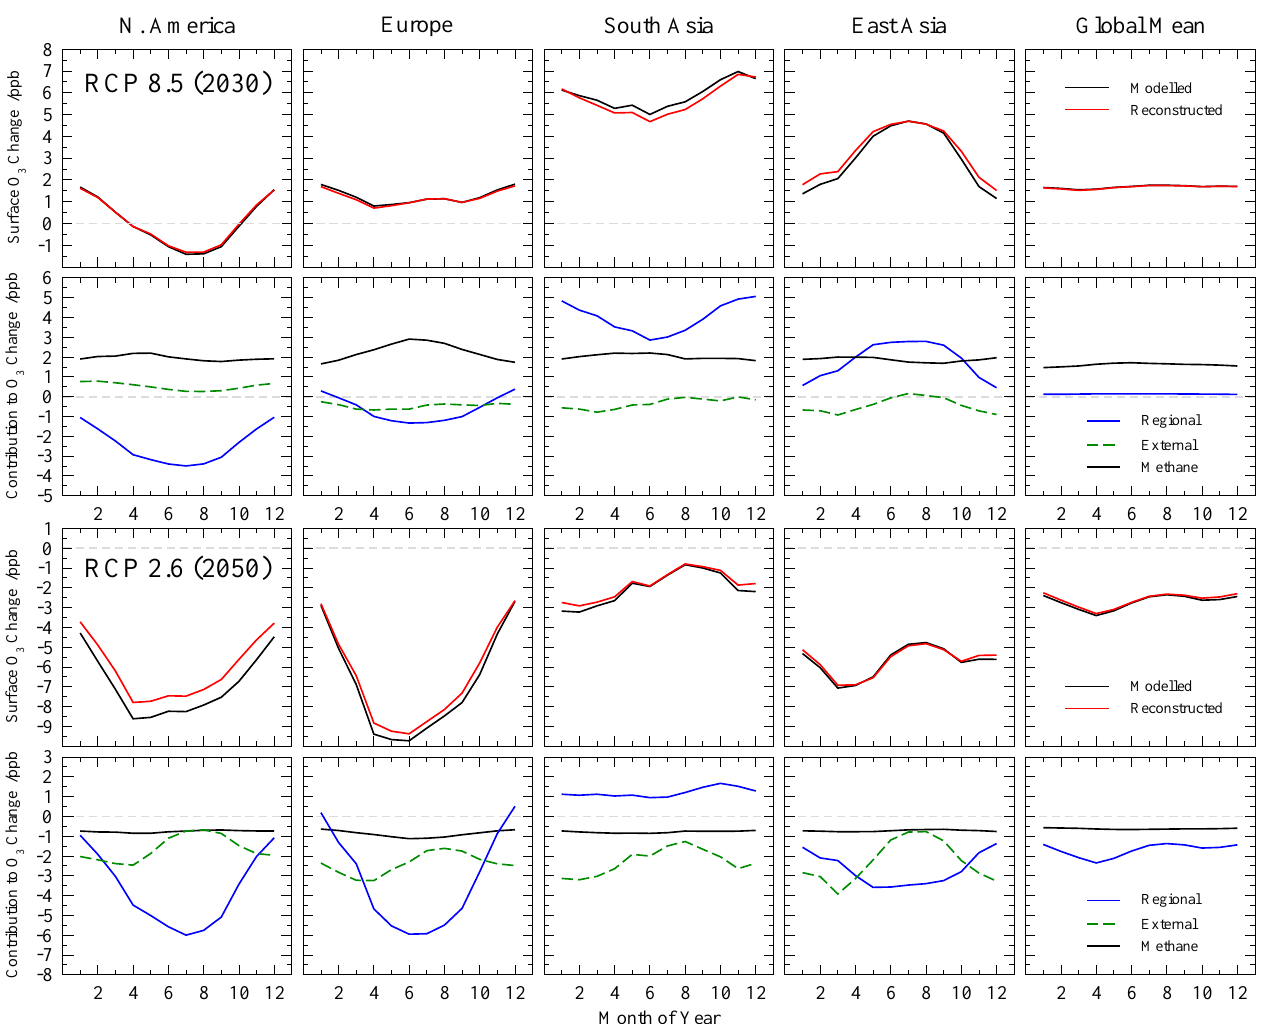
Fig. 4. Monthly regional mean surface O 3 changes in the FRSGC/UCI CTM between 2000 and 2030 for the RCP 8.5 emissions (upper panel) and between 2000 and 2050 for the RCP 2.6 emissions (lower panel). The upper row of each panel shows the estimated O 3 response compared with that from a full simulation, and the lower row shows the attribution of the O 3 response to global CH 4 changes (black) and to emission changes inside (blue) and outside (green) the source